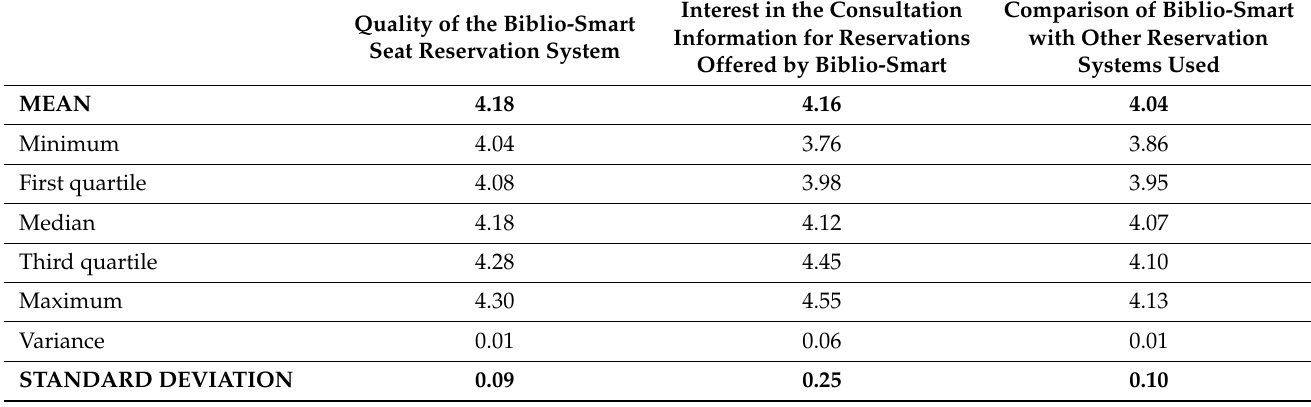
Table 7. Summary of indicators of the three variables analyzed, including their standard